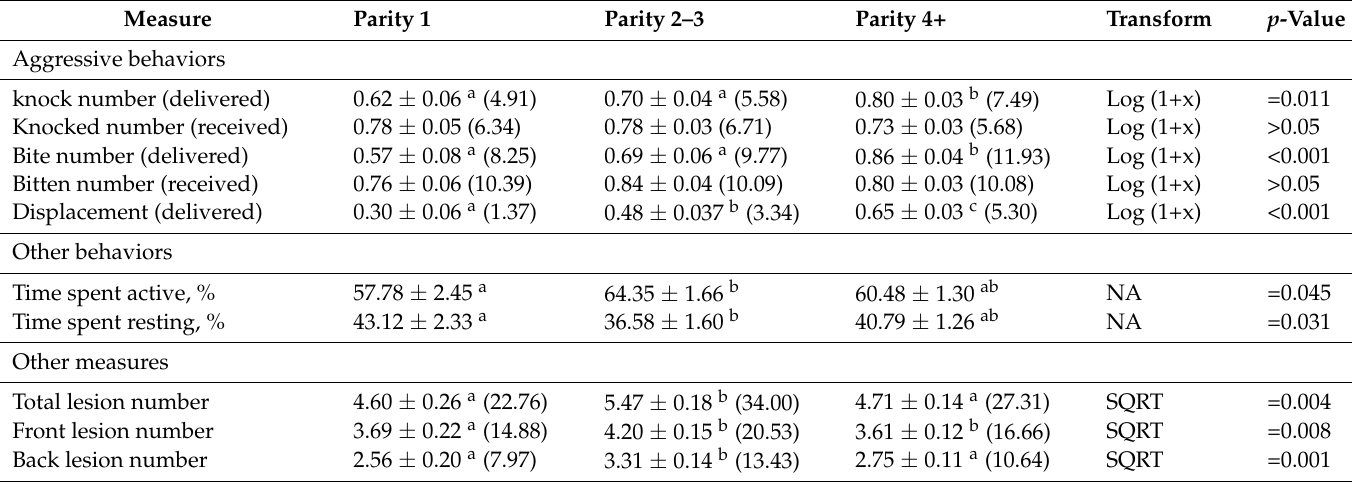
Table 4. Effect of parity at mixing on the number of or percentage of total time spent in certain aggressive and non-aggressive behaviors, and other variables associated with these behaviors, in group housed gestating domestic sows 1,2